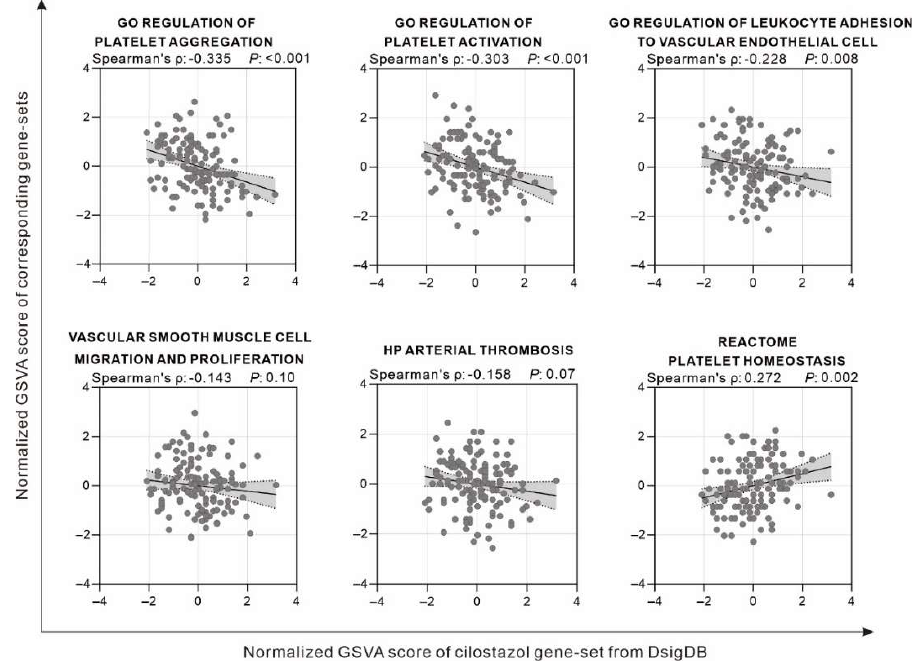
Figure 1. Association of GSVA score of cilostazol gene-set with various thrombosis-related gene sets investigated in GSE19151.